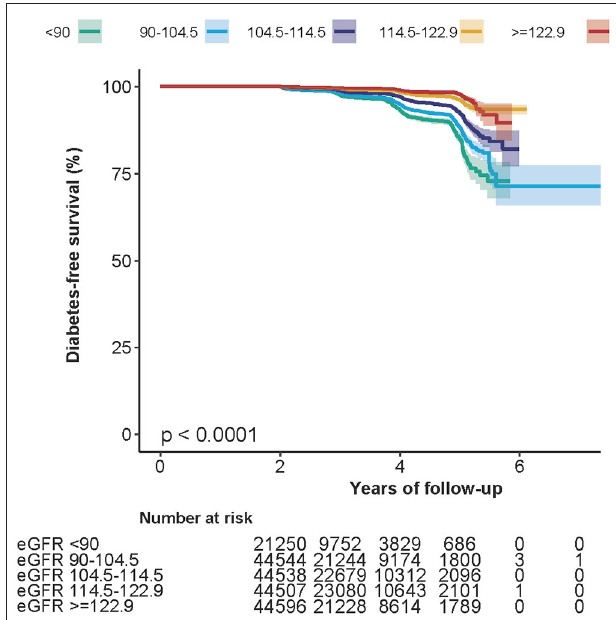
FIGURE 1 | Kaplan–Meier event-free survival curve. Kaplan–Meier analysis of incident diabetes-free survival based on eGFR groups (log-rank, p < 0.0001).